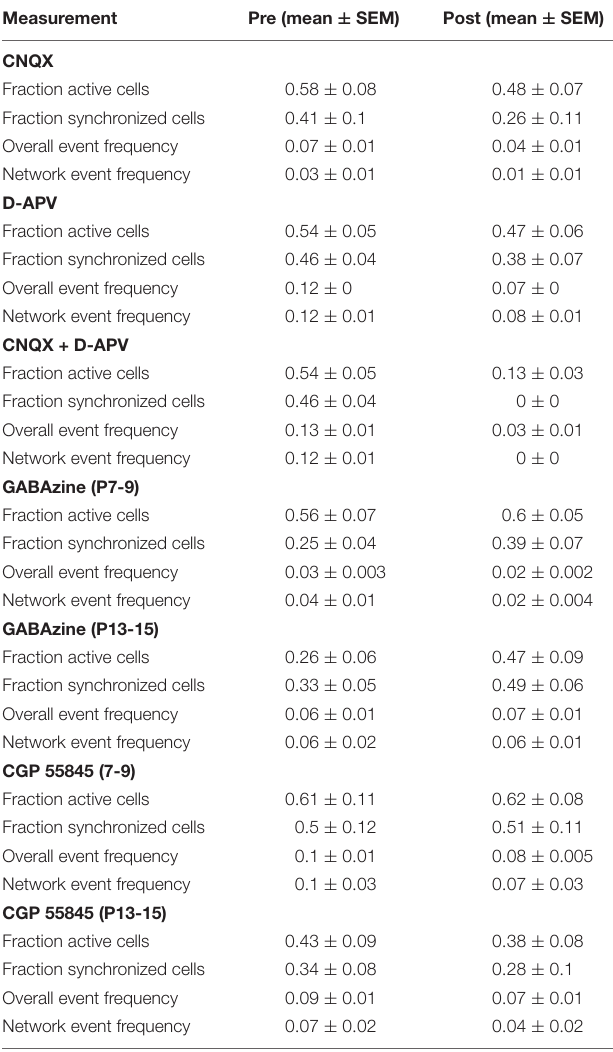
TABLE 1 | Non-normalized values for all data shown in Figures 4 , 5 .